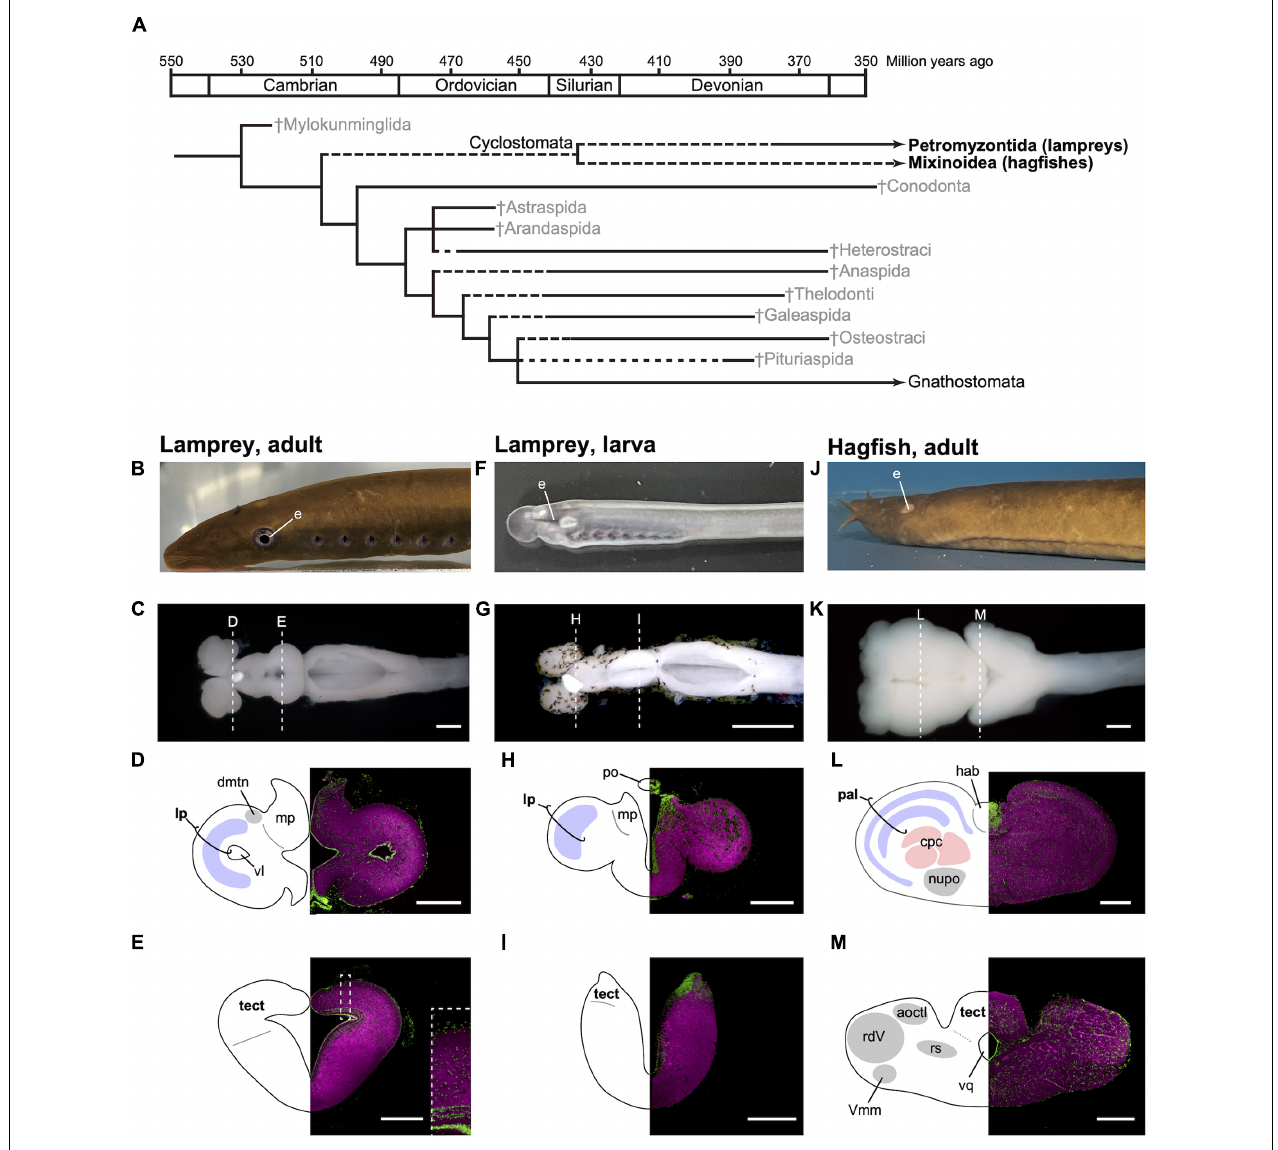
FIGURE 1 | Phylogenetic tree of early vertebrates and brain sections of the cyclostomes. (A) Cladogram showing the postulated relationships of the jawless fishes and the Gnathostomata (jawed fishes) based on morphological characters (based on Benton, 2015). (B–E) Lateral view of adult lamprey ( Lethenteron camtschaticum , B ), dorsal view of the brain (C) , and its transverse brain sections at the forebrain (D) and midbrain (E) levels. The laminated structure of the optic tectum is magnified in the inset of (E) . (F–I) Lateral view of larval lamprey (F) , dorsal view of the brain (G) , and its transverse brain sections at the forebrain (H) and midbrain (I) levels. The photograph for (G) is reproduced from Suzuki and Grillner (2018). (J–M) Lateral view of adult hagfish ( Eptatretus burgeri , J ), dorsal view of the brain (K) , and its transverse brain sections at the forebrain (L) and midbrain (M) levels. Sections are immunostained by anti-acetylated tubulin antibody (Sigma, T6793, magenta ) and counterstained with Fluorescent Nissl Stain (Invitrogen N21480, green ). acoctl, area octavolateralis; cpc, central prosencephalic complex; dmtn, dorsomedial telencephalic nucleus; hab, habenular ganglion; lp, lateral pallium; mp, medial pallium; nupo, nuclei praeoptici; pal, pallium; po, pineal organ; tect, tectum; rdV, radix descendens nervi trigemini; rs, formation reticularis, pars superior; vl, ventriculus lateralis; Vmm, nucleus motorius magnocellularis nervi trigemini; vq ventriculus quartus. Scale bars: 1 mm for (C,G,K) ; 500 µ m for (D,E,L,M) ; 200 µ m for (H,I)